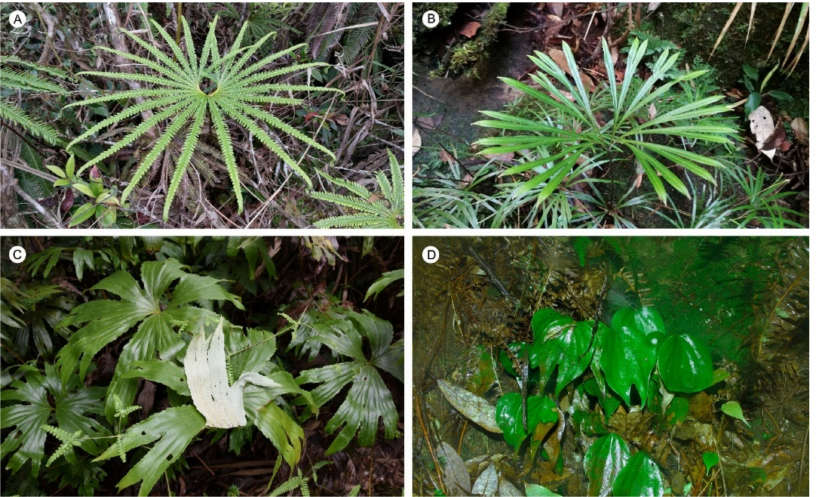
Figure 6. The habit of species from Matoniaceae and Dipteridaceae. ( A ): Matonia pectinata ; ( B ): Dipteris lobbiana ; ( C ): Dipteris chinensis ; and ( D ): Cheiropleuria bicuspis